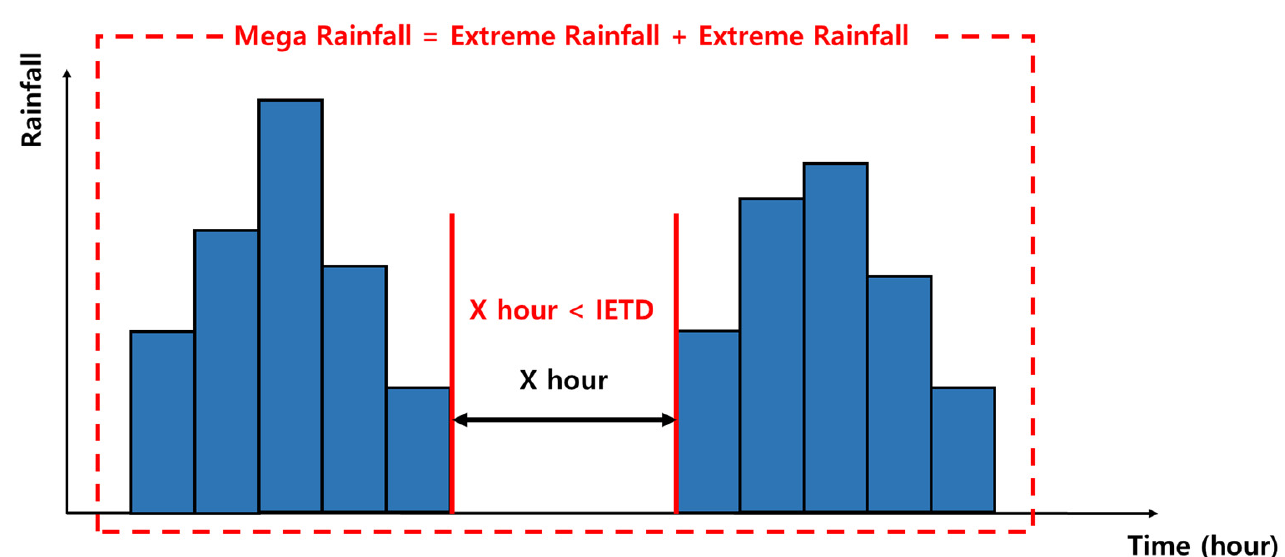
Figure 2. Definition of mega rainfall event using IETD; mega rainfall event consists of two extreme rainfall events that have an inter-arrival time less than IETD.